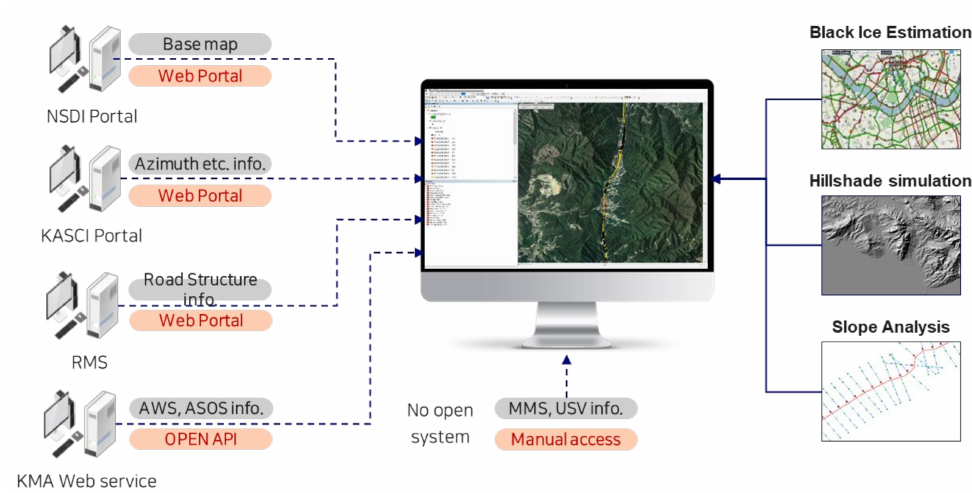
Figure 9. System architecture of the proposed method.